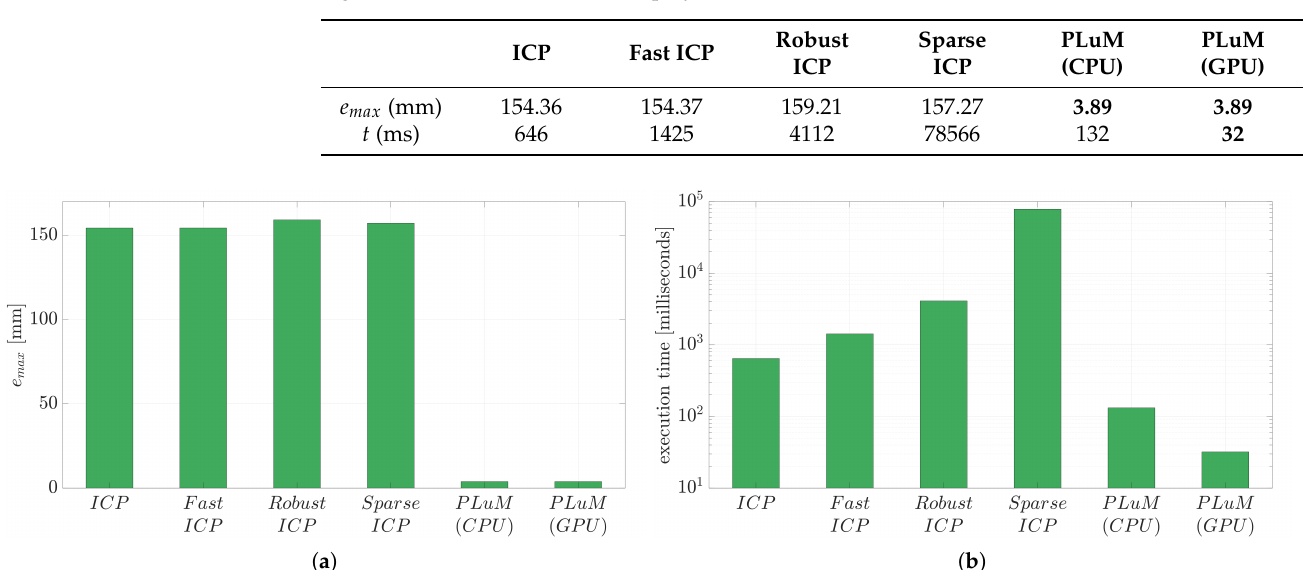
Figure 8. The reported results for the problem depicted in Figure 7a. ( a ) Displays the maximum vertex error ( e max ), and ( b ) compares the execution time. Table 3. The maximum vertex error and execution time for each method in the problem depicted in Figure 7b. The best results are displayed in bold.